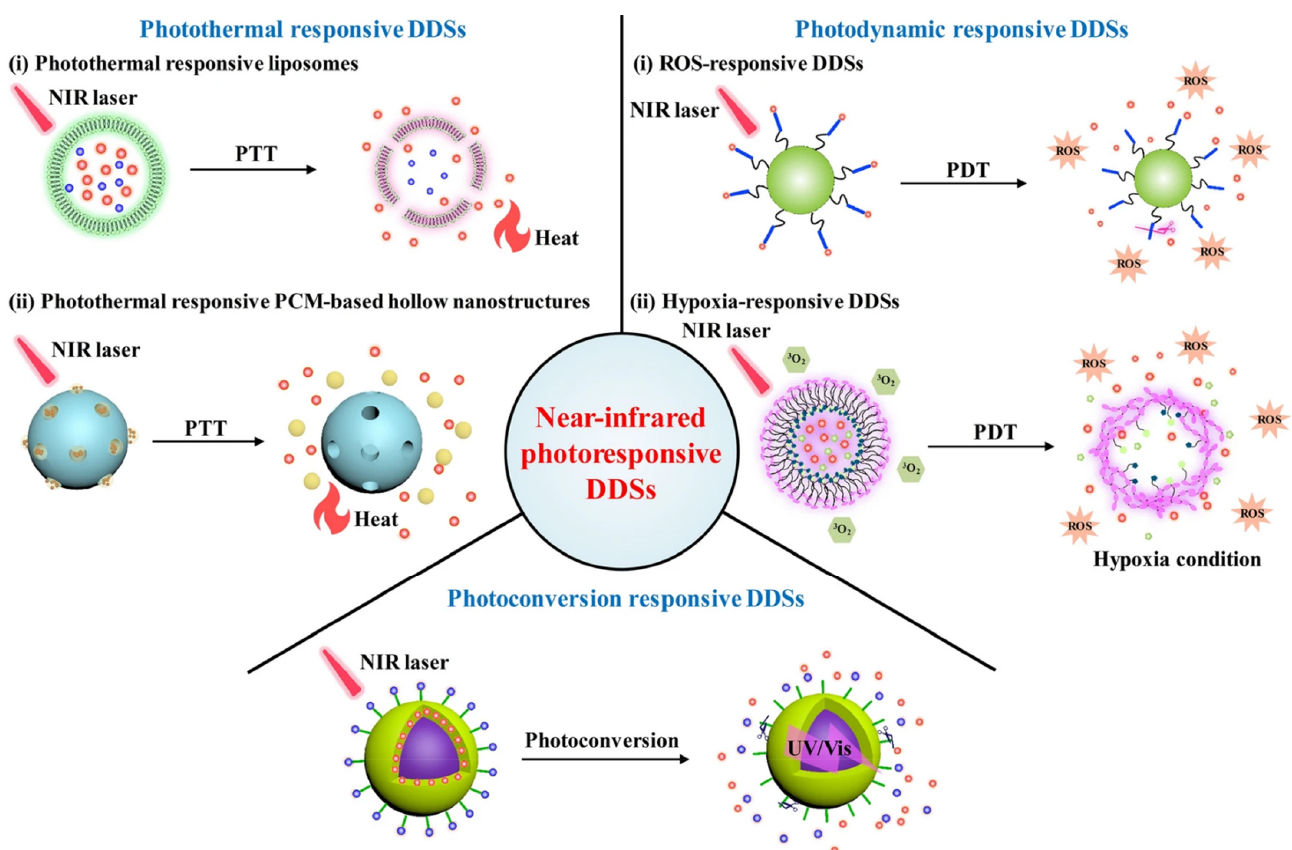
Figure 4. Temperature/photosensitive micelles entrapping drugs that are released in the presence of NIR. Note: drug delivery systems (DDSs); near-infrared (NIR), (650–950 nm); photothermal therapy (PTT); photodynamic therapy (PDT); reactive oxygen species (ROS); reproduced from [62] CC-BY License.